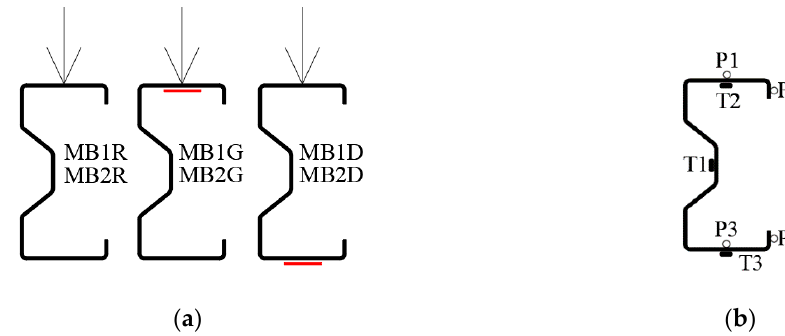
Figure 2. Tested beams: ( a ) sample symbols and Carbon Fiber Reinforcement Polymer/Plastic (CFRP) tapes location; ( b ) measuring points—electrofusion strain gauges (T1, T2, T3) and displacement measurement points (P1, P2, P3, P4), located at the very center of the beam span.